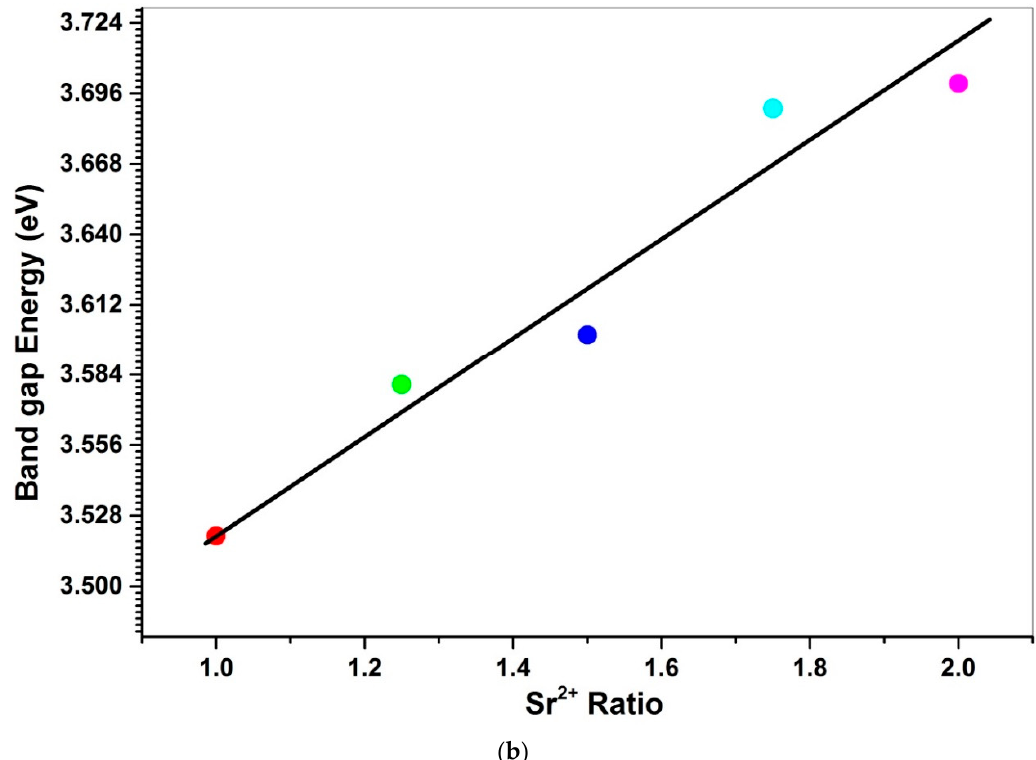
Figure 10. ( a ) Tauc plot depicting the energy band gap in the Ba 2 − x Sr x ZnWO 6 (x = 1, 1.25, 1.50, 1.75, 2) double perovskite series; ( b ) The relationship between band gap energy and ratio of Sr 2+ . Table 4. Band gap energy (according to absorption edge and Tauc plot for direct transition) for the Ba 2 − x Sr x ZnWO 6 (x = 1, 1.25, 1.50, 1.75, 2.00) double perovskite series. X Ratio X = 1 X = 1.25 X = 1.50 X = 1.75 X = 2 Cut-o ff wavelength (nm) 388 345 343 337 E g (eV) by cuto ff wavelength E g (eV) by Tauc